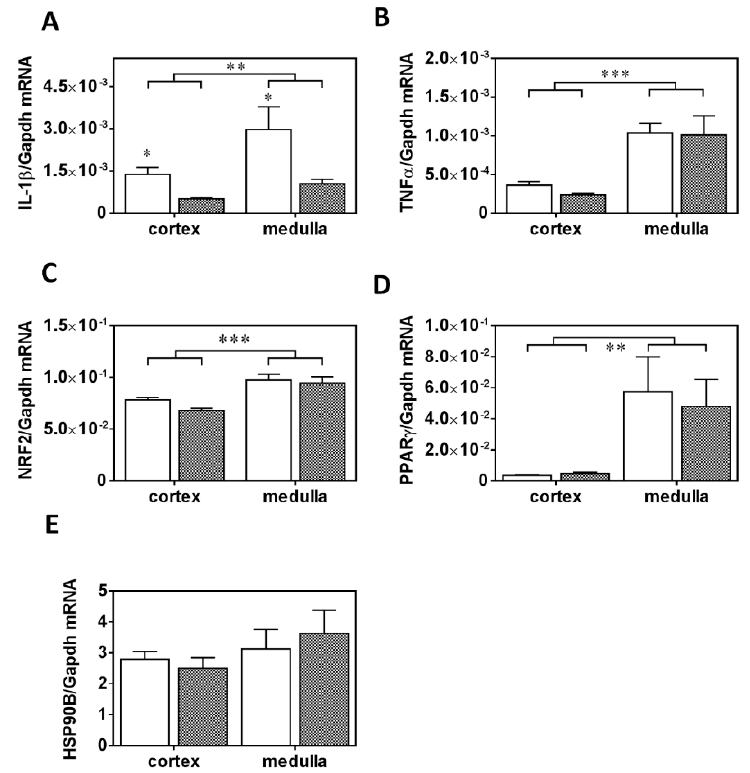
Figure 7. mRNA expression of inflammatory, oxidative stress and metabolic markers in the kidney ( A ) IL-1 β , ( B ) TNF α , (C) Nrf2 , ( D ) PPAR γ , and ( E ) HSP90B mRNA expression in kidney cortex and medulla in obese prediabetic (PRED, gray columns) and control (CON, white columns) rats at the end of study. Data are means ± SEM, two-way RM ANOVA, n8-9/group ( A – E ); *: p < 0.05, **: p < 0.01; ***: p < 0.0001.